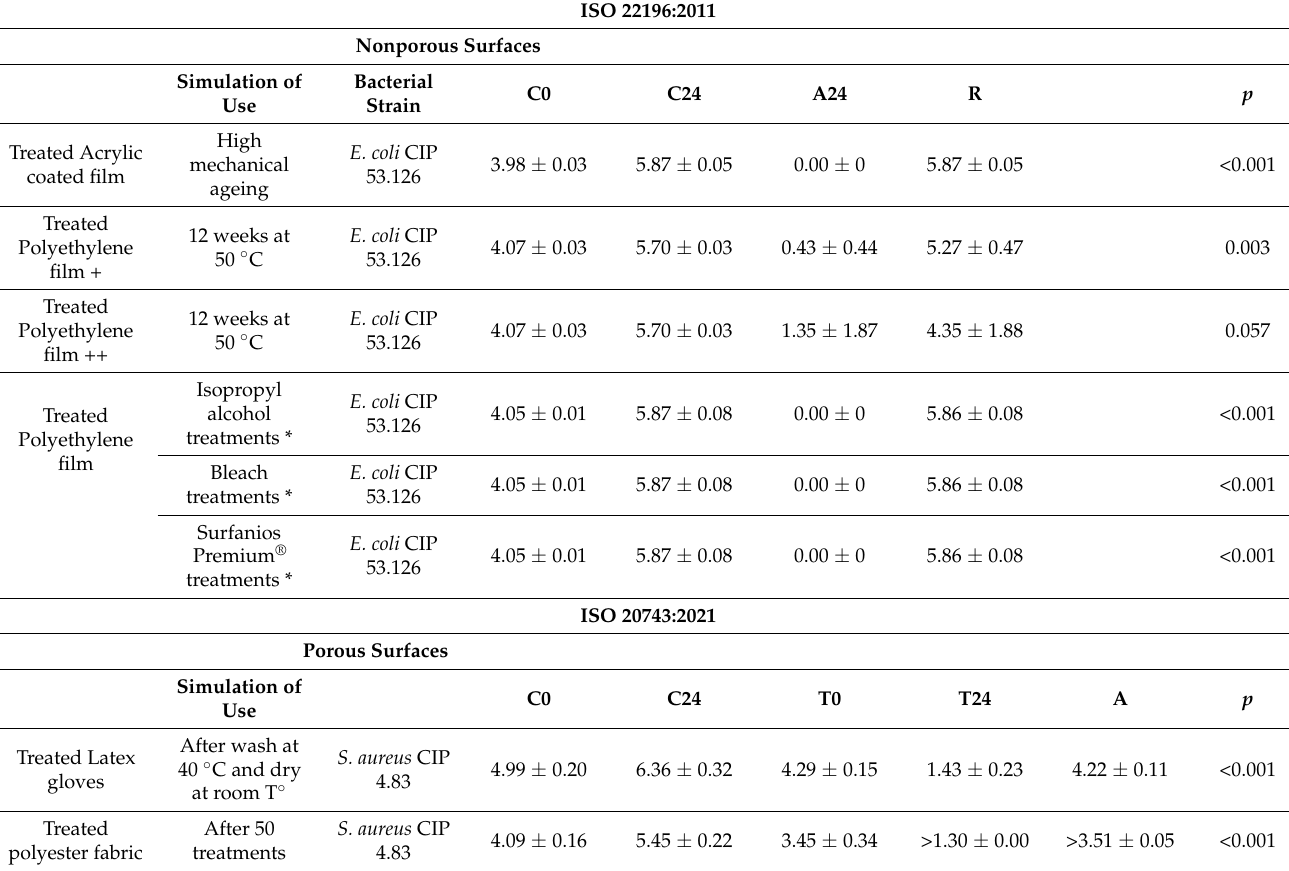
Table 6. Worst-case scenarios in vitro simulation test. Log CFU numerations after 0 h (control C0) and 24 h (control C24 and assay A24) of contact with different types of surfaces and log reductions per cm 2 with E. coli CIP 53.126 (nonporous surfaces) and S. aureus CIP 4.83 (porous surfaces). ISO